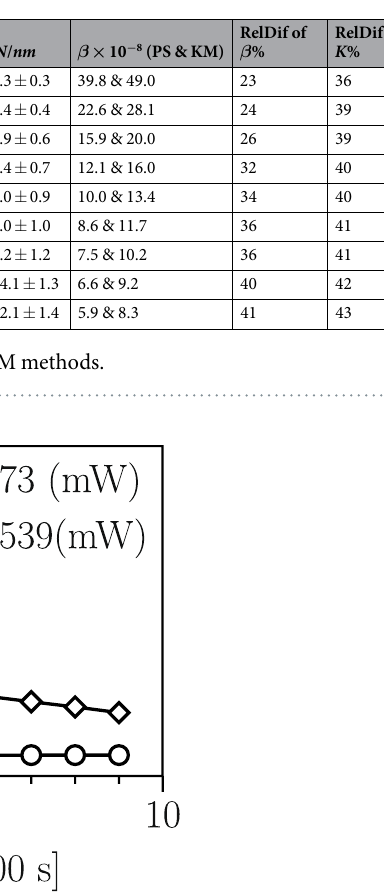
Figure 10. Non-diverging behavior of diffusion coefficient. The limit Δ t → 0 of M (2) ( x = 0, Δ t )/ Δ t (the diffusion coefficients) for two laser powers 73 mW and 539 mW. This indicates finite values of the diffusion coefficients in that limit (red